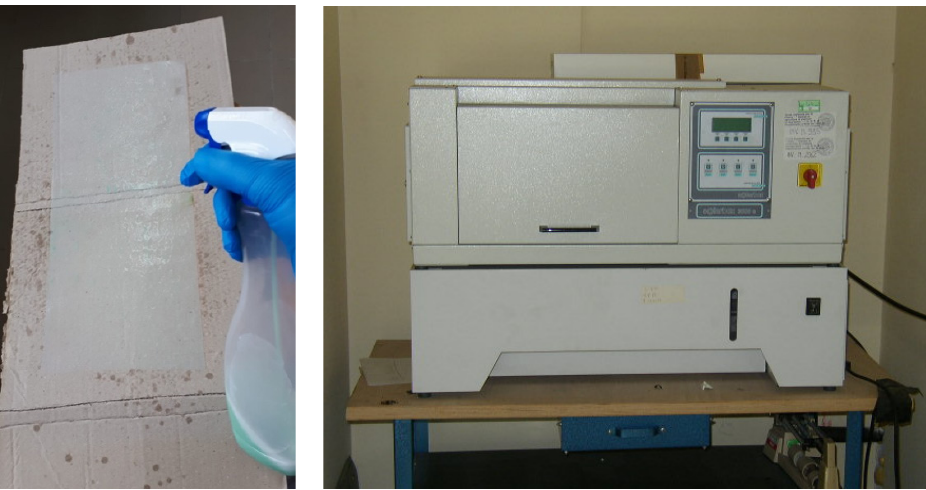
Figure 1. Agrochemicals spraying in the laboratory ( left ) and ageing chamber ( right ).